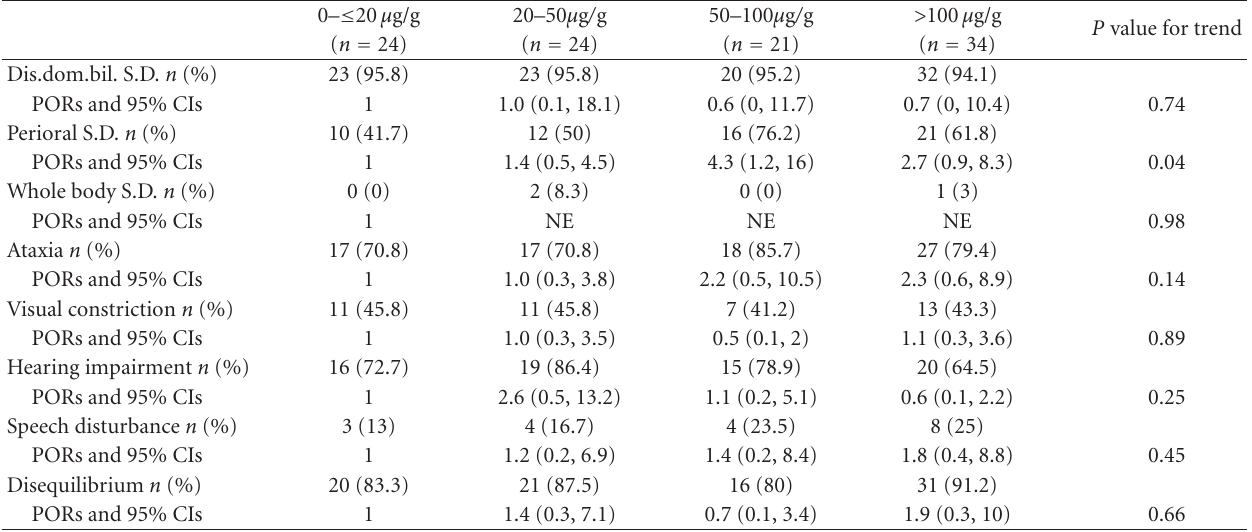
Table 3: Adjusted PORs ∗ and their 95% C.I.s between mercury content and neurological